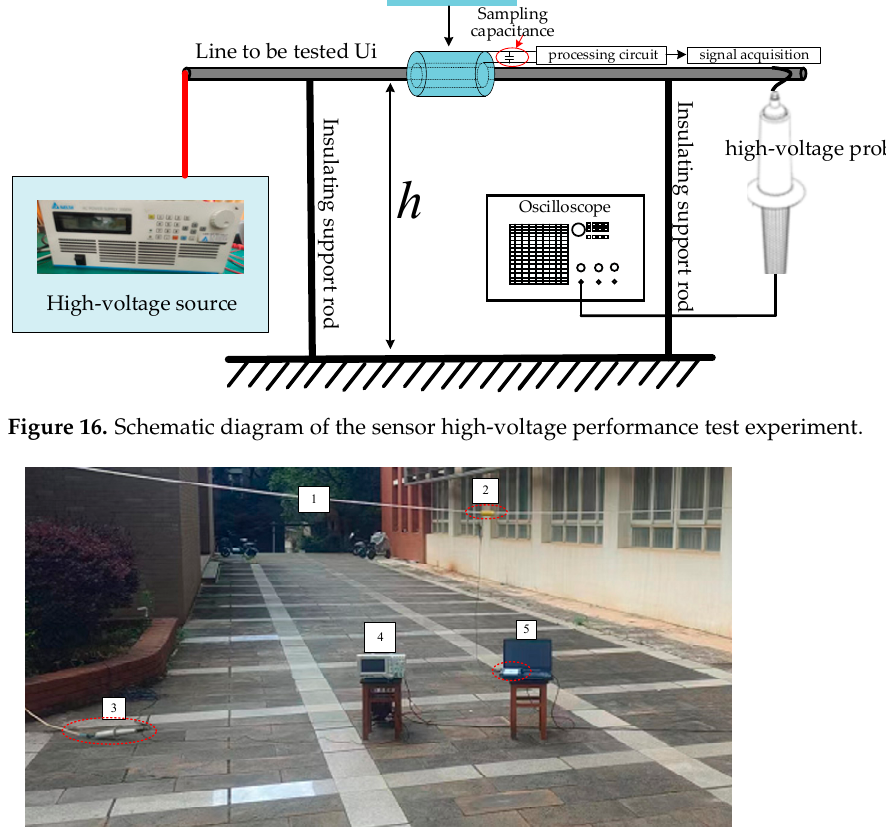
Figure 17. Sensor high-voltage performance test platform.